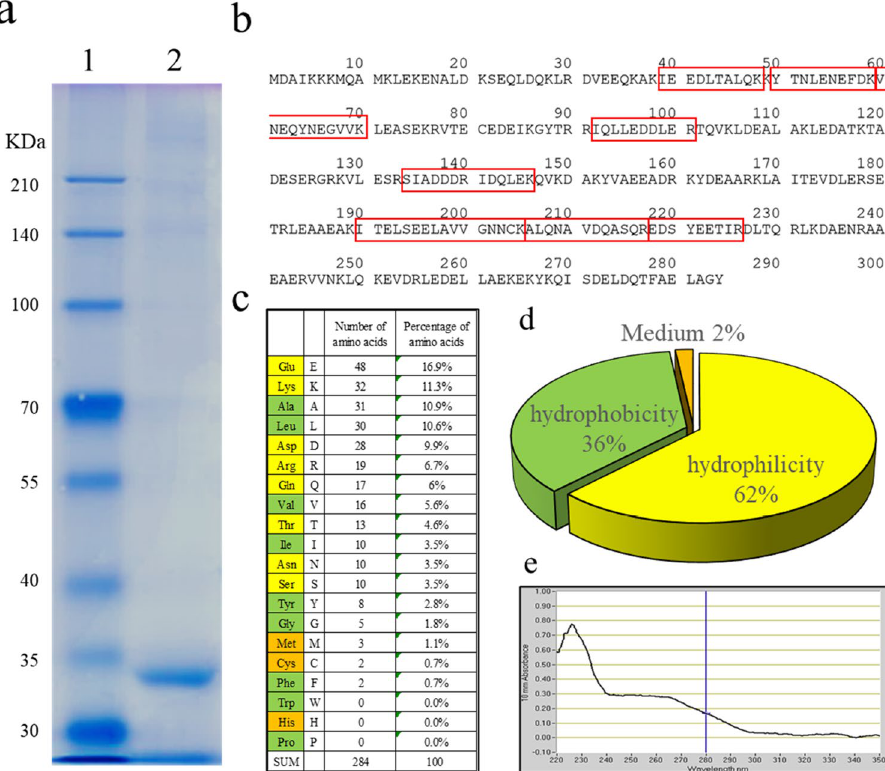
Figure 3. Identification of proteins using SDS-PAGE and MALDI-TOFMSMS, and amino acid composition of the characterised proteins. ( a ) SDS-PAGE of boiled basket clam soup. ( b ) Deduced amino acid sequence of Japanese basket clam ( Corbicula japonica ) tropomyosin. Amino acids surrounded by red boxes are the parts detected using MALDI-TOF–MS/MS. ( c ) Amino acid composition of Japanese basket clam ( C. japonica ) tropomyosin. ( d ) Ratio of hydrophilic/hydrophobic/amphoteric amino acids. ( e ) UV absorption of basket clam extract from 220 to 350